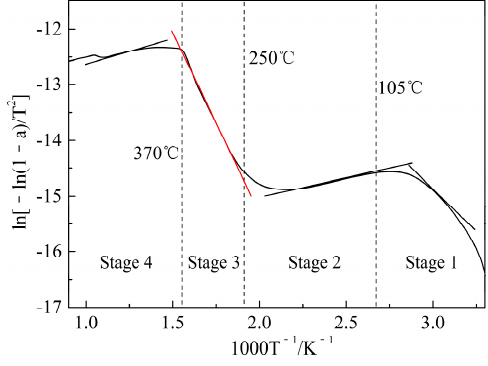
Figure 6. The plot of ln[ − ln(1 – α )/T 2 ] versus 1000/T.